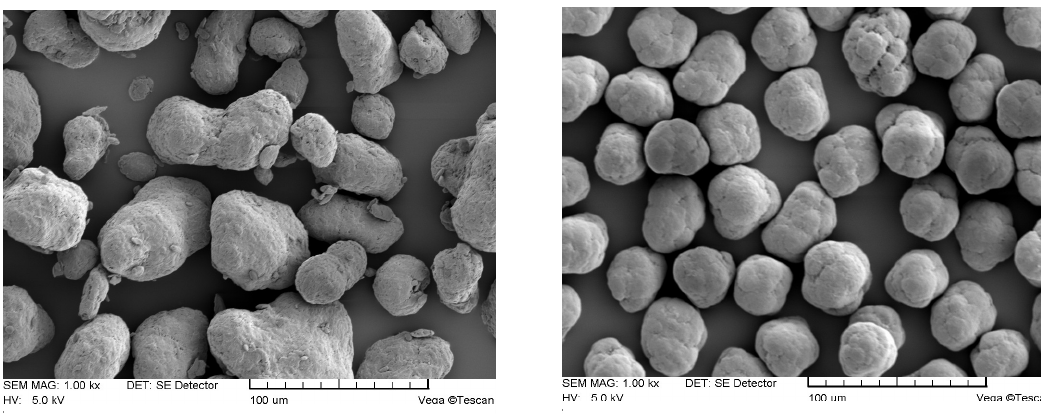
Figure 1. Different morphology of the particles caused by the production process.